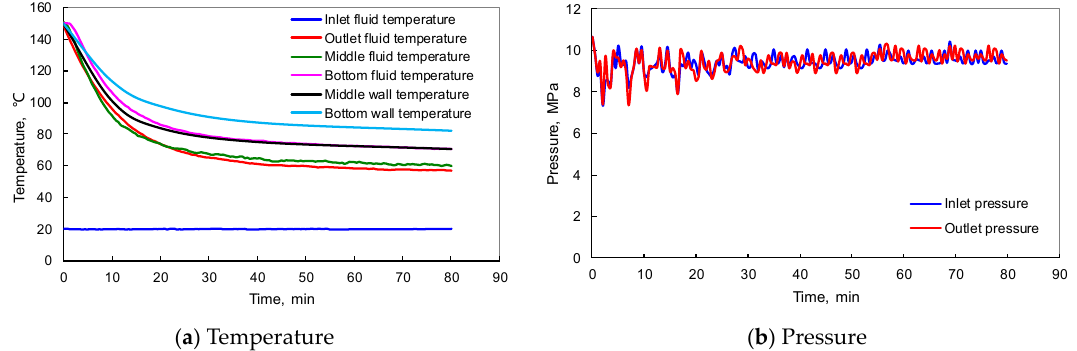
Figure 3. The variation of temperature and pressure in the heat exchange tube with time.